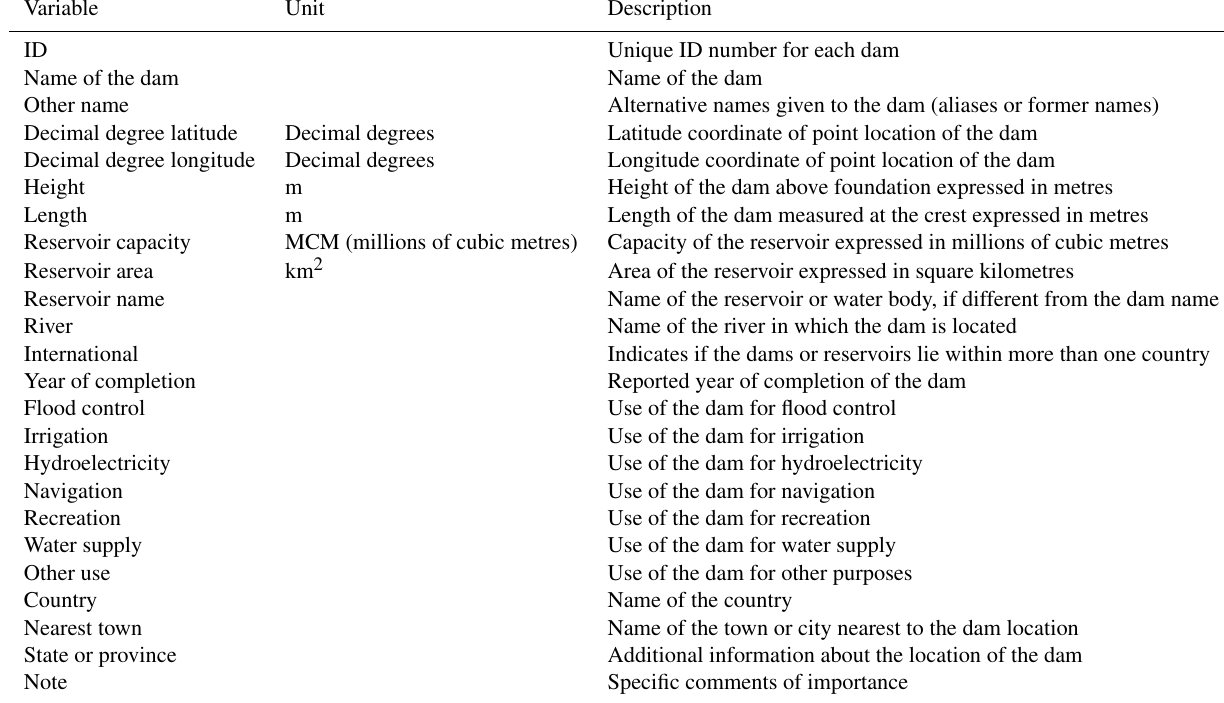
Table 3. List of variables processed for dams and